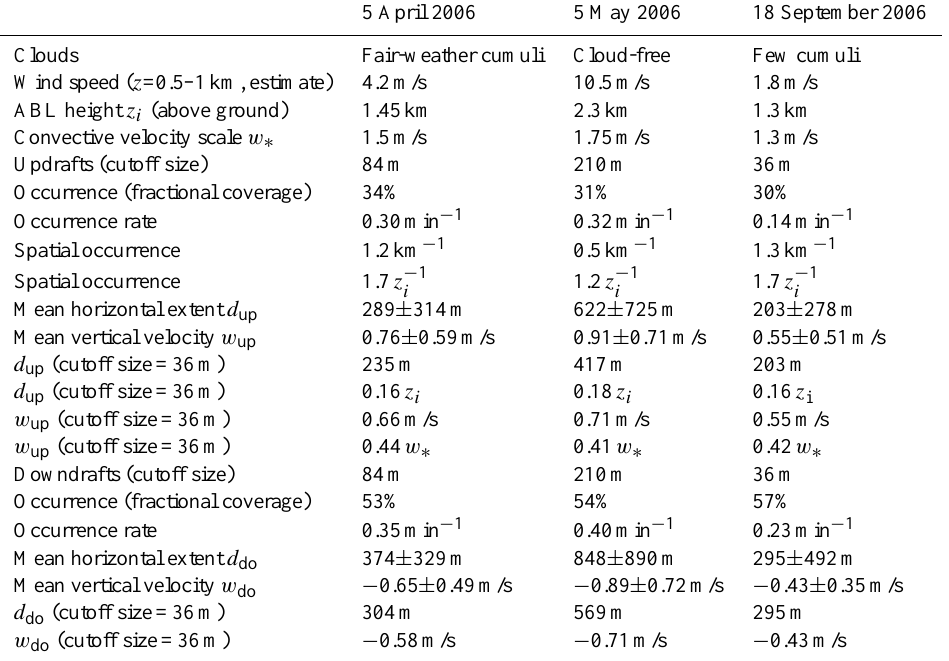
Table 1. Summary of updraft and downdraft properties for the three cases discussed. Mean values (and partly standard deviations) are presented for the time period from 12:00–17:00LT on 5 May and 18 September and from 12:00–16:45LT on 5 April, and by considering the vertical velocity times series for the height levels of 645, 870, and 1170m on 5 April and 5 May. Occurrence parameters for the 18 September are computed from the data sampled at the 645m height level only. The integrated occurrence time (fractional coverage in percent) is related to the total 4.75h and 5h observation periods, occurrence rate is calculated from the number of detected drafts during the total period of 4.75–5h. Mean horizontal extent is simply obtained by the mean draft occurrence period (in seconds) multiplied by the estimated wind speed given in the table. Minimum horizontal size (cutoff size) of counted drafts is indicated in the table (84m, 210m, 36m). Estimates of draft mean size and velocity for a cutoff size of 36m are given in